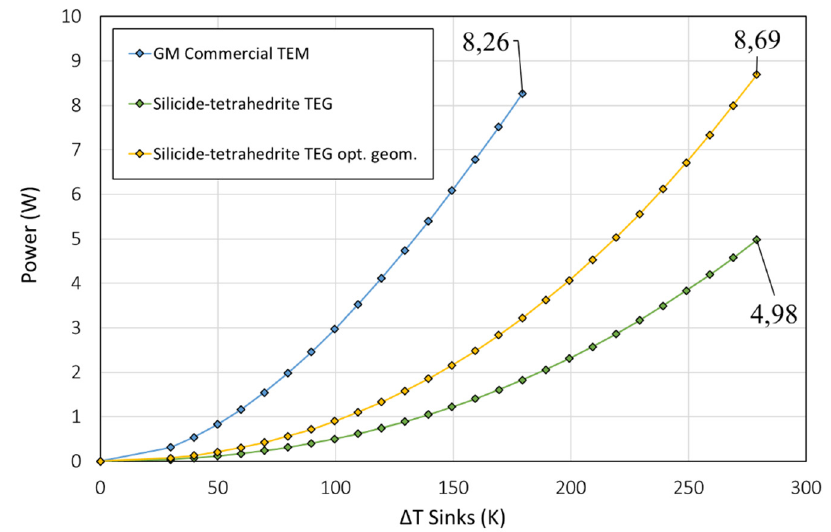
Figure 5. Power as a function of the Δ T between sinks (IFDM 1D).